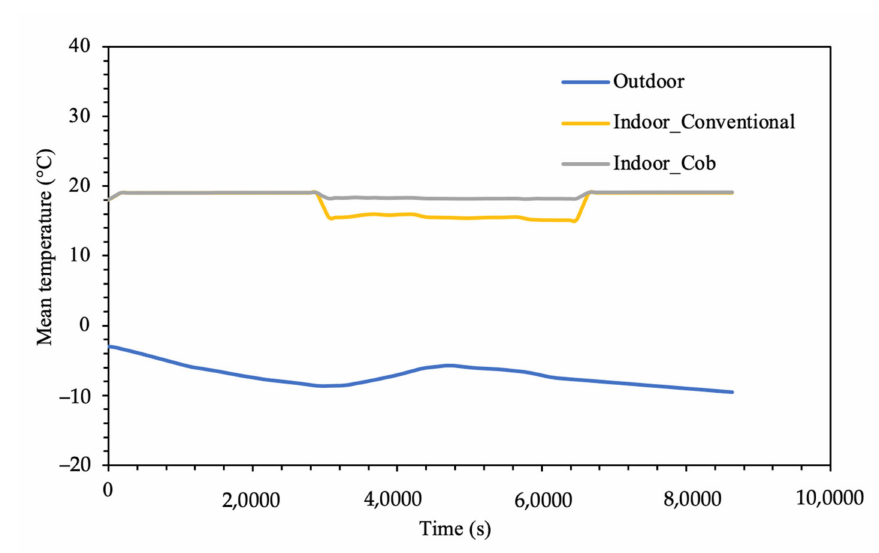
Figure 19. Mean indoor temperature for the two cases in the coldest day.